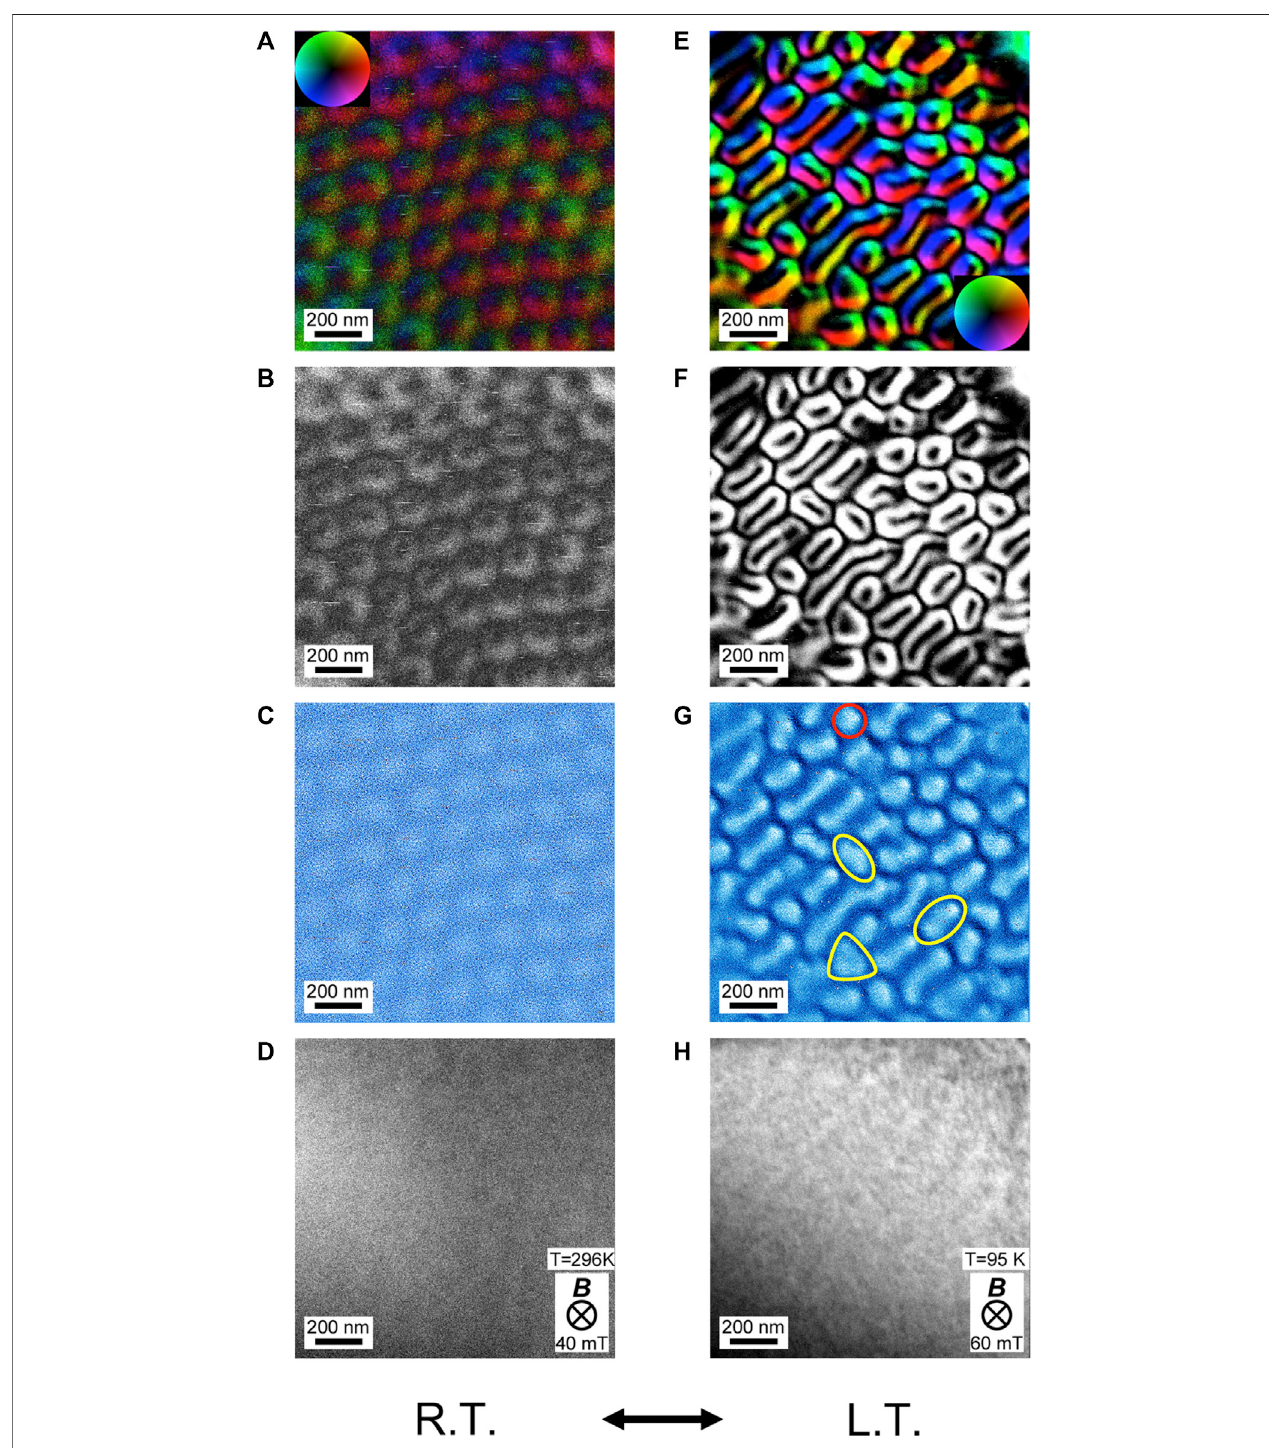
FIGURE 1 | Differential phase contrast scanning TEM images of skyrmion lattices in a thin plate of Co 8 Zn 8 Mn 4 at room temperature (296 K) (A – D) and at a low temperature (95 K) (E – H) . (A , E) In-plane magnetic induction as a color map and (B , F) intensity. (C , G) Magnetic helicity images [35] and (D , H) simultaneously acquired annular dark- fi eld images. The same pixel dwell time of 640 μ s was used to record these images. Perpendicular magnetic fi elds of 40 and 60 mT are applied at 296 and 95 K, respectively. Yellow shapes indicate several deformed skyrmions, not only in shape but also in size, while a red circle indicates less deformed circular skyrmions in (G) .